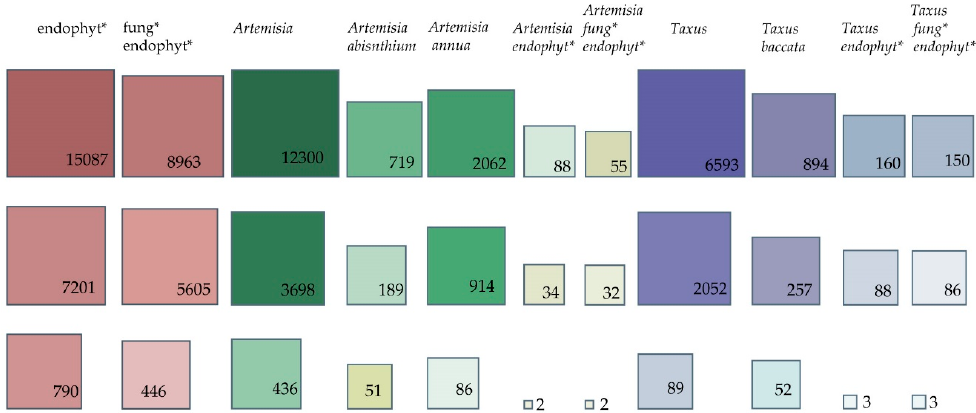
Figure 1. Survey of the literature in databases (Scopus—first upper line of squares; PubMed—middle line with squares; and CAB Direct—bottom line with squares) with indexed keywords related to host plants and endophytes. * = Keywords were used as shown in the figure except for the PubMed